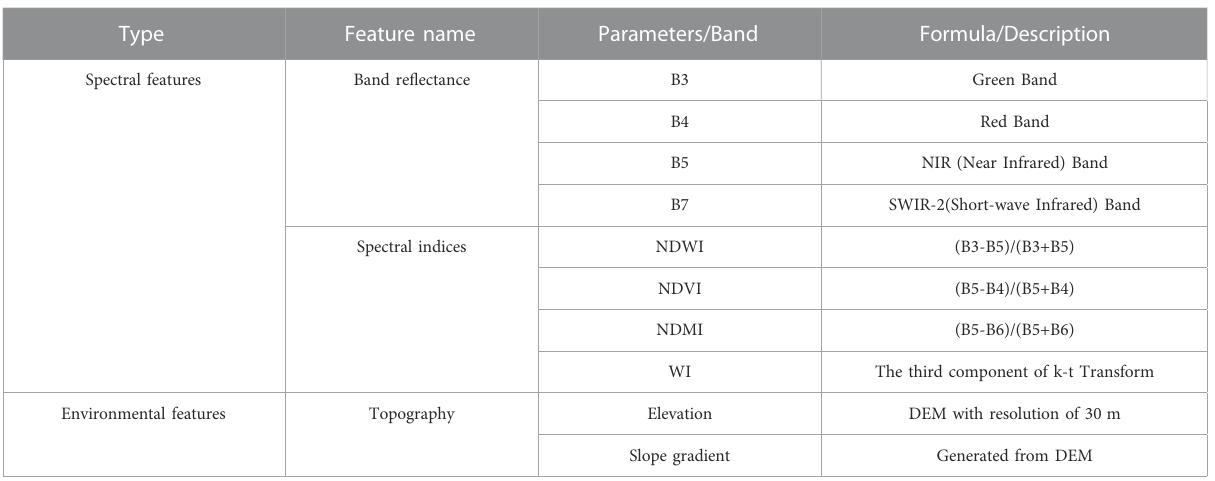
TABLE 3 Feature list of image object identi fi cation for wetland classi fi